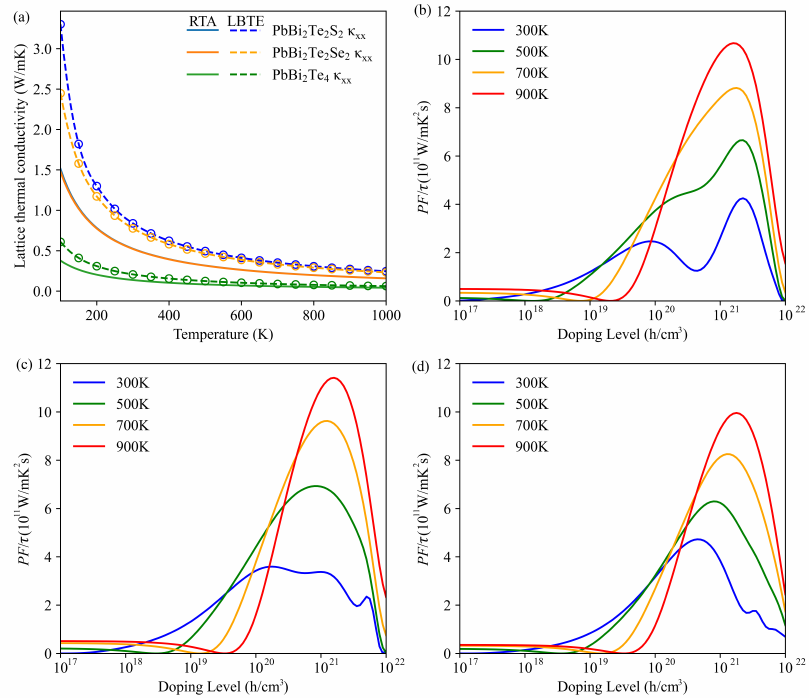
Figure 5. ( a ) Lattice thermal conductivity of the PbBi 2 Te 2 S 2 , PbBi 2 Te 2 Se 2 and PbBi 2 Te 4 as a function of temperature obtained from LBTE (dash lines) and RTA (solid lines) in the a-axis direction. Figure of merit versus hole doping level at various temperatures for PbBi 2 Te 2 S 2 ( b ), PbBi 2 Te 2 Se 2 ( c ), and PbBi 2 Te 4 ( d